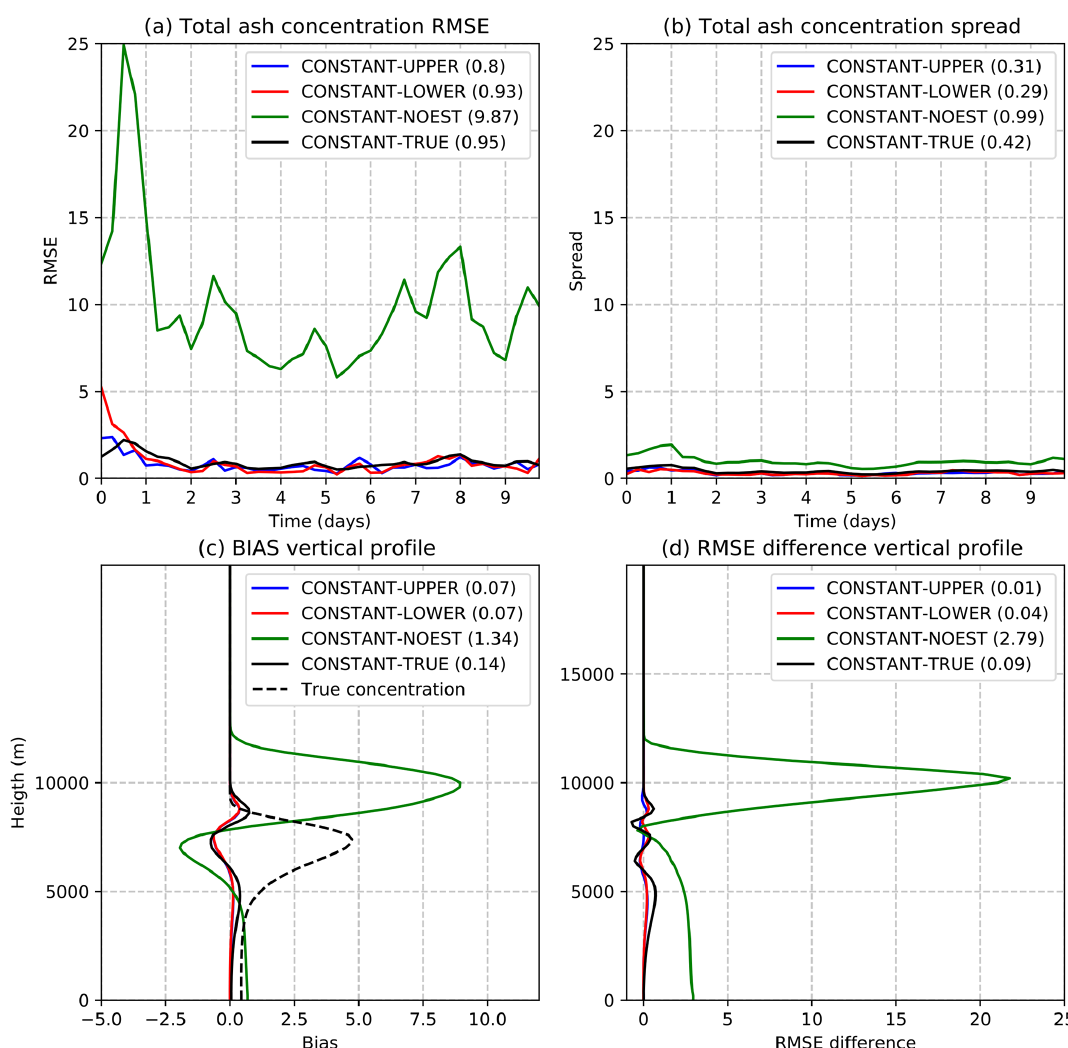
Figure 7. (a) Spatially averaged forecasted total ash concentration RMSE, (b) spatially averaged forecasted total ash concentration ensemble spread, (c) spatially averaged forecasted total ash concentration bias, and (d) the difference between the 6h forecast and analysis total ash concentration RMSE for the CONSTANT-UPPER (blue line), CONSTANT-LOWER (red line), CONSTANT-TRUE (black line), and CONSTANT-NOEST (green line) experiments. Panels (a) , (b) , and (c) are computed from the 6h ensemble forecast (all values: 10 − 3 gm − 3